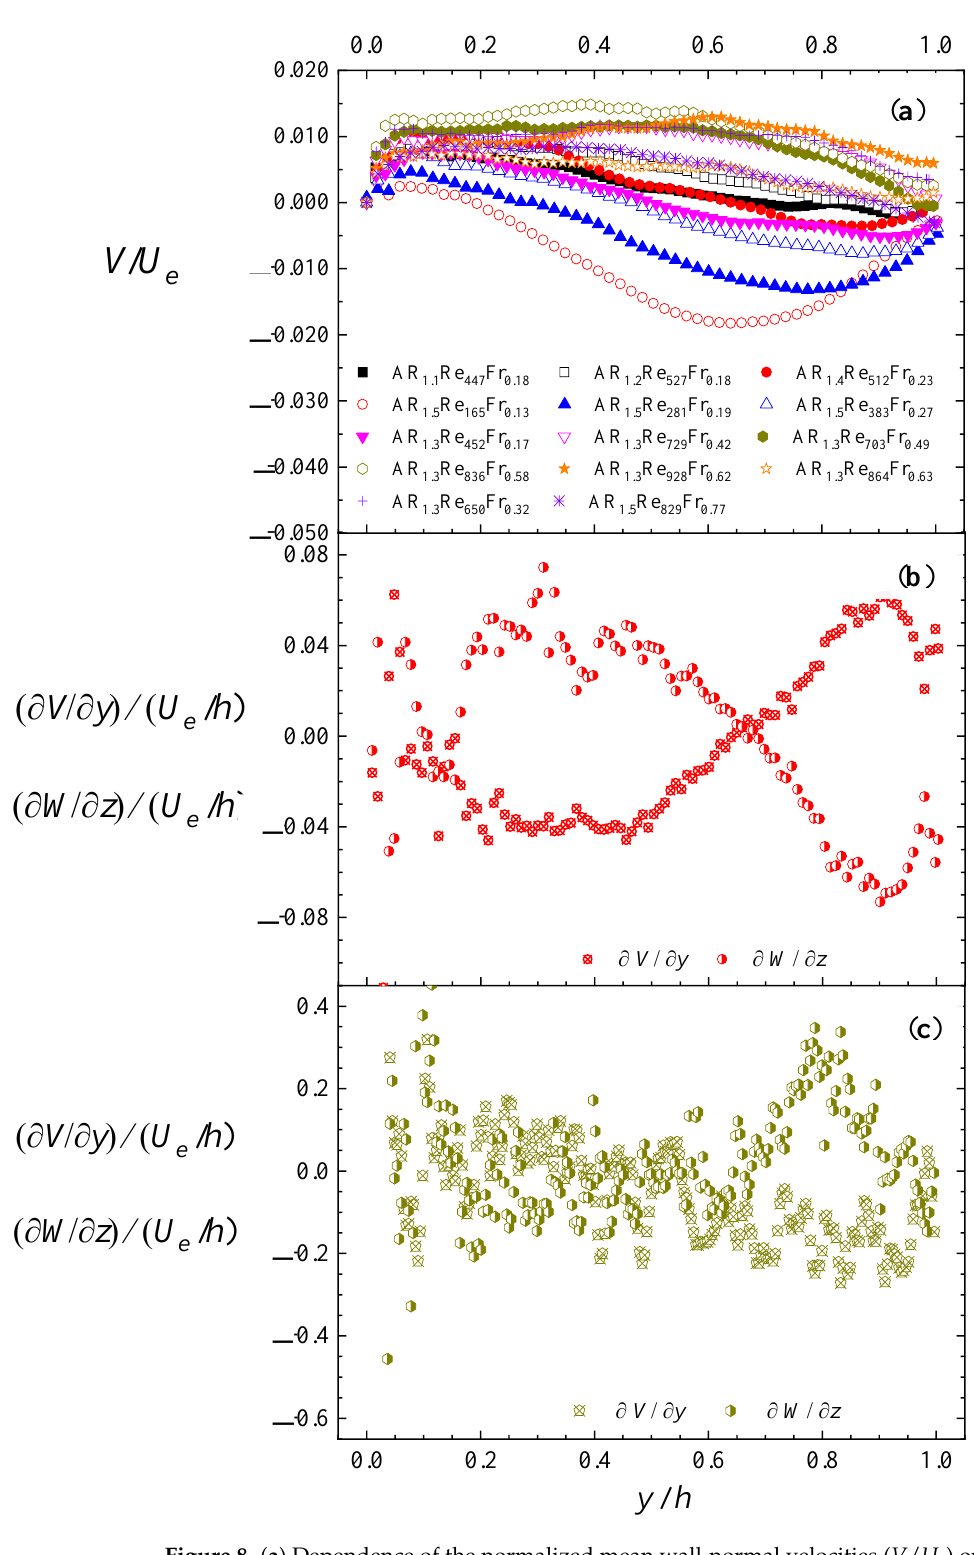
Figure 8. ( a ) Dependence of the normalized mean wall-normal velocities ( V / U e ) on the wall-normal location. Gradients of the streamwise wall-normal and spanwise velocities ( ∂ V / ∂ y and ∂ W/ ∂ z ) for ( b ) AR 1.5 Re 165 Fr 0.13 and ( c ) AR 1.3 Re 836 Fr 0.58 .